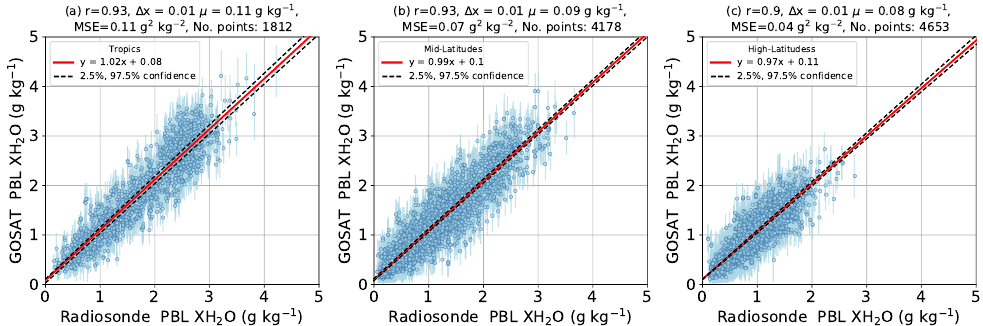
Figure 9. Comparison of GOSAT PBL XH 2 O over 3 broad latitudinal bands for same 8 year collocation period (June 2009 to May 2017): ( a ) Tropics ( ± 30 ◦ ), ( b ) Mid-Latitudes (45 ◦ S–30 ◦ S, 30 ◦ N–45 ◦ N) and ( c ) High-Latitudes (> ± 45 ◦